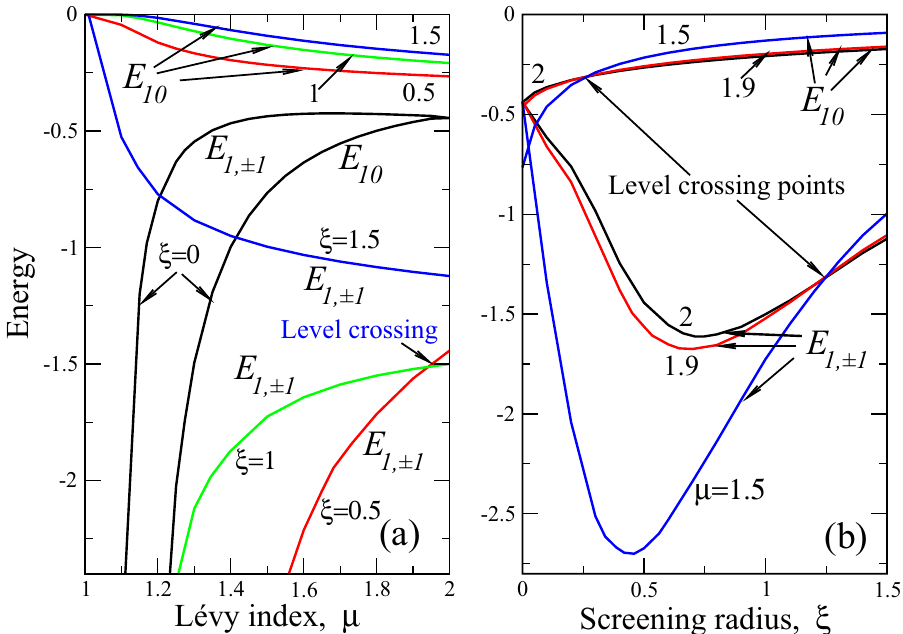
Figure 4. Same as in Fig. 3 but for the first excited state E 10 and E 1, ± 1 . Lifting of orbital degeneracy, related to Runge–Lenz vector conservation at µ = 2 , is seen for entire µ and ξ domains (except one point ξ = 0 , µ = 2 , at which E 00 = E 1, ± 1 = 0.4444 (29)), where E 00 = E 1, ± 1 . The curves E 00 and E 1, ± 1 , corresponding to the same ξ (panel (a)) or µ (panel (b)), are coded by the same color (black for ξ = 0 , red for ξ = 0.5 , green for ξ = 1 and blue for ξ = 1.5 in panel (a) as well as black for µ = 2 , red for µ = 1.9 and blue for µ = 1.5 in panel (b)) and also by figures near curves. As dependencies of E 00 and E 1, ± 1 on screening radius ξ are nonmonotonous (see panel (b)), we show explicitly which curves correspond to E 00 and which to E 1, ± 1 in both panels. The positions of level crossing points are also